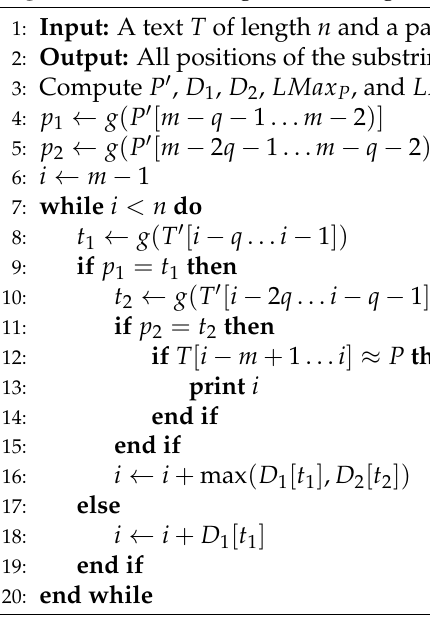
Algorithm 1 OPPM algorithm using